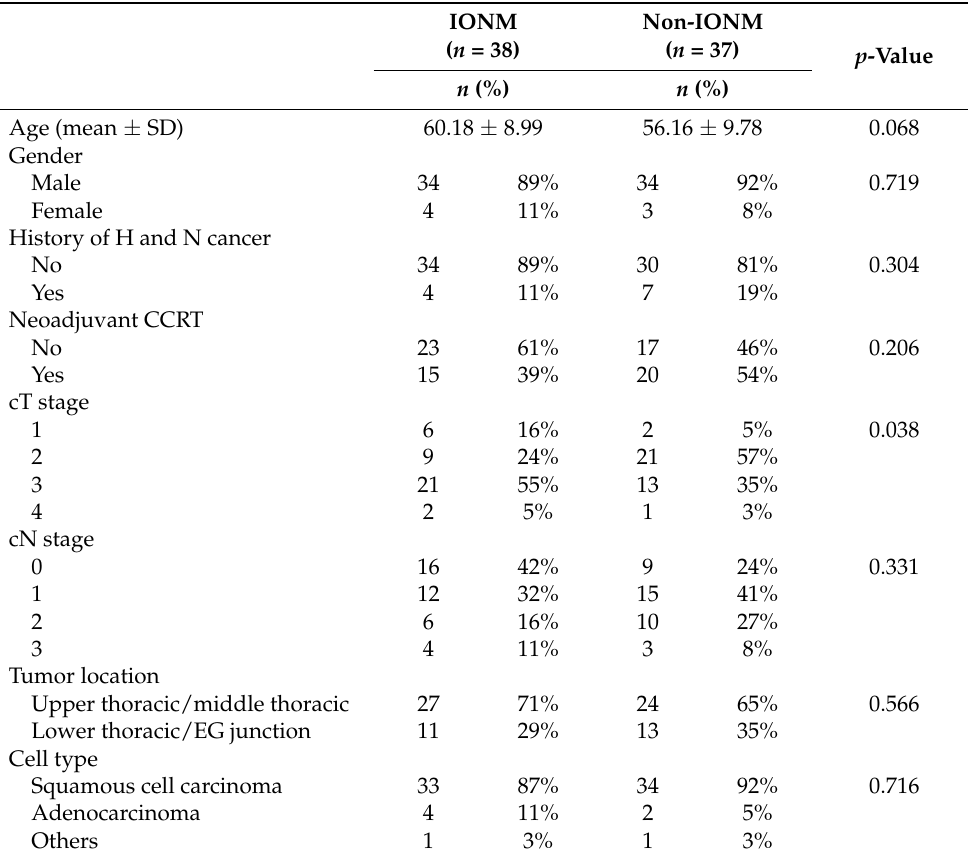
Table 1. Patient characteristics.